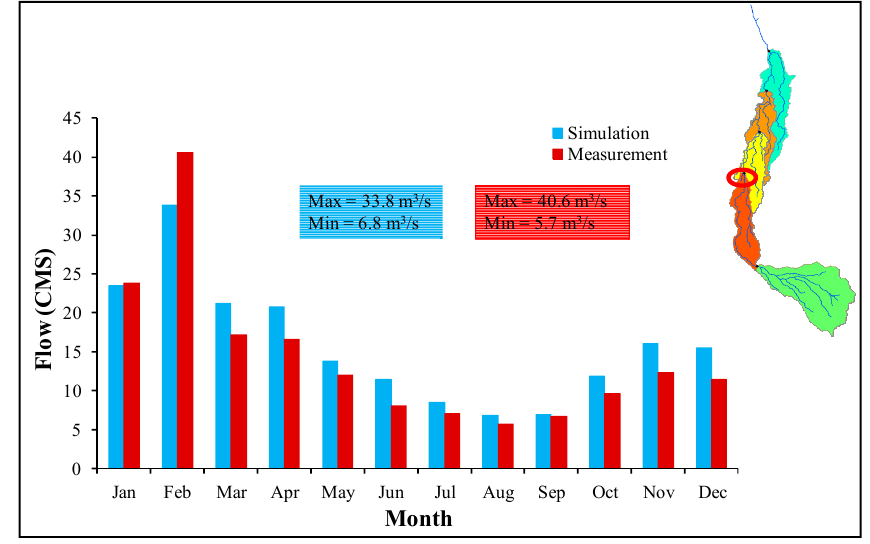
Figure 6. Comparison of the simulated and observed average monthly discharges at Kp Kelapa for the period 2000–2007. (Here CMS- Cubic Meter per Second).